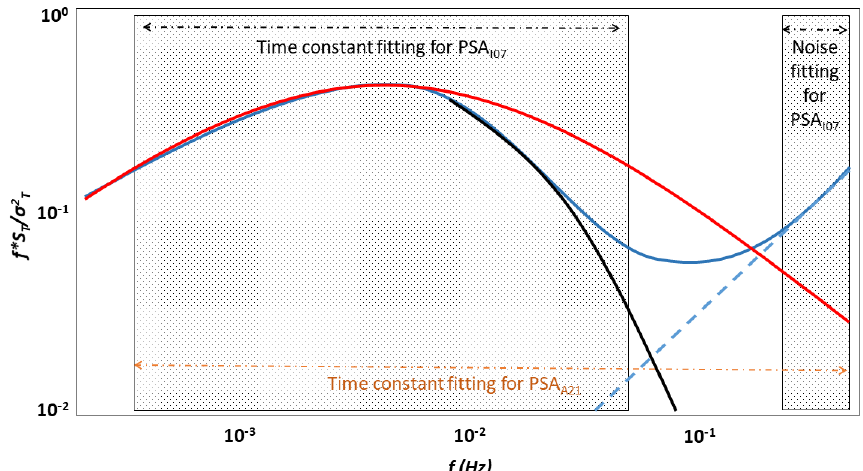
Figure 1. A diagram illustrating fitting procedures for PSA methods. Shown are the spectra of unattenuated and noise-free temperature (red line) and spectra of low-pass filtered and noisy scalar before (solid blue line) and after (black line) noise removal. For PSA I07 , the noise is detected via fitting a line (dashed blue) to the high-frequency end of noisy scalar over the frequency range highlighted. Then, it is extended towards lower frequencies and subtracted from the noisy spectrum, yielding noise-free spectra. Later, the time constant is calculated via fitting Eq. (4) to noise-free spectra over the frequency range highlighted. For PSA A21 , the time constant is obtained from one comprehensive fitting of Eq. (7) to noisy spectra over the whole frequency range